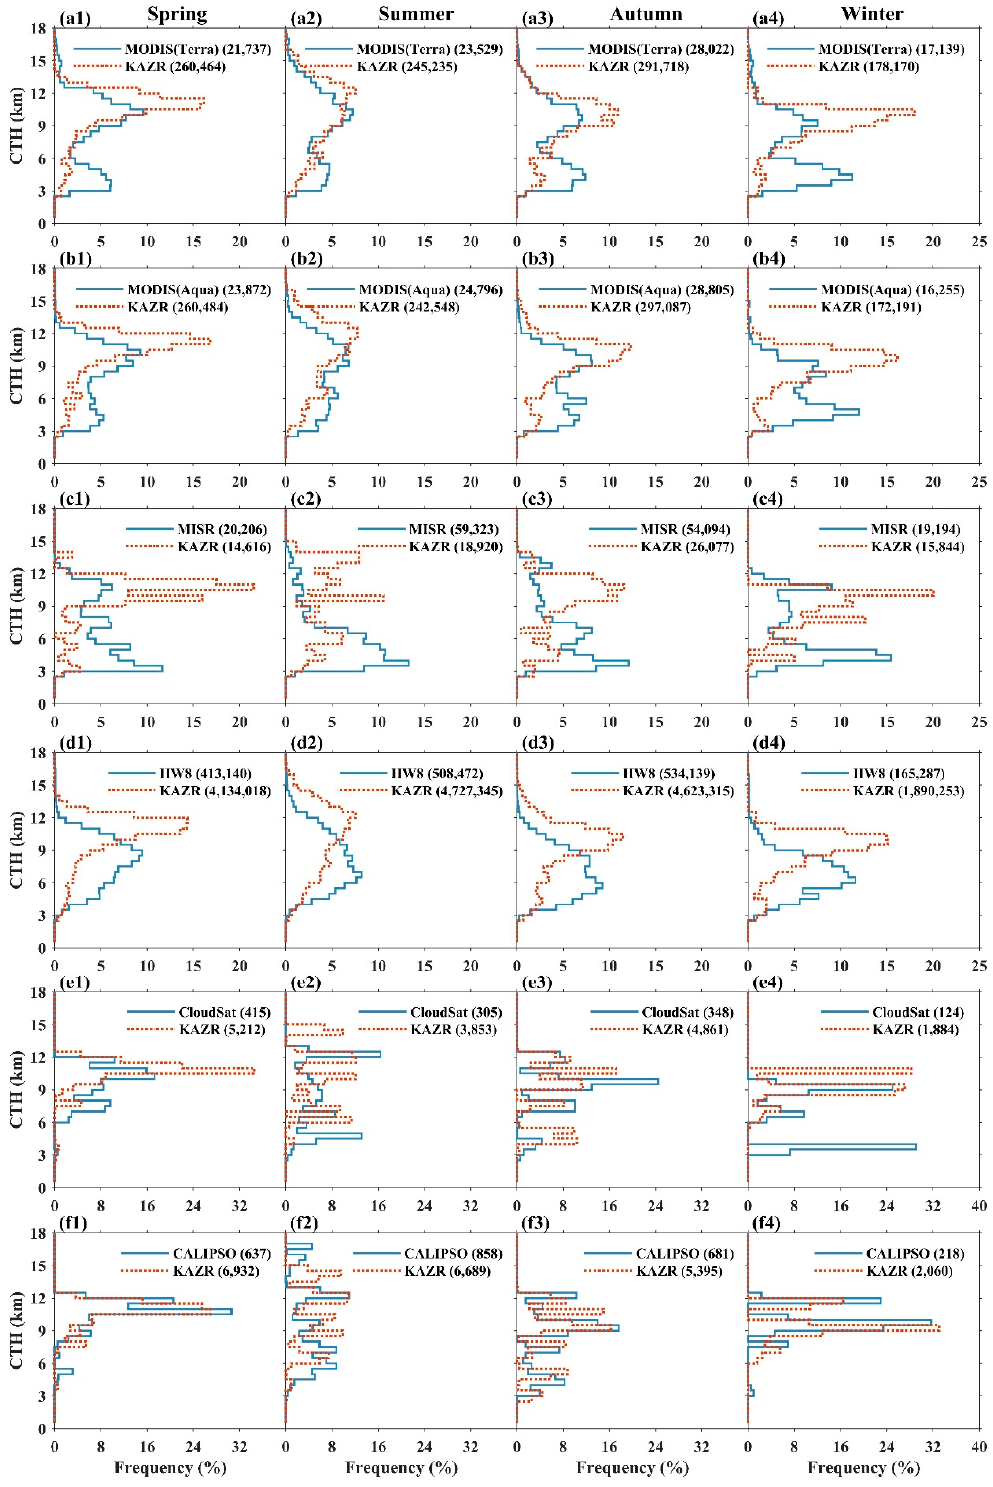
Figure 8. Same as Figure 4 but for overlapping clouds.